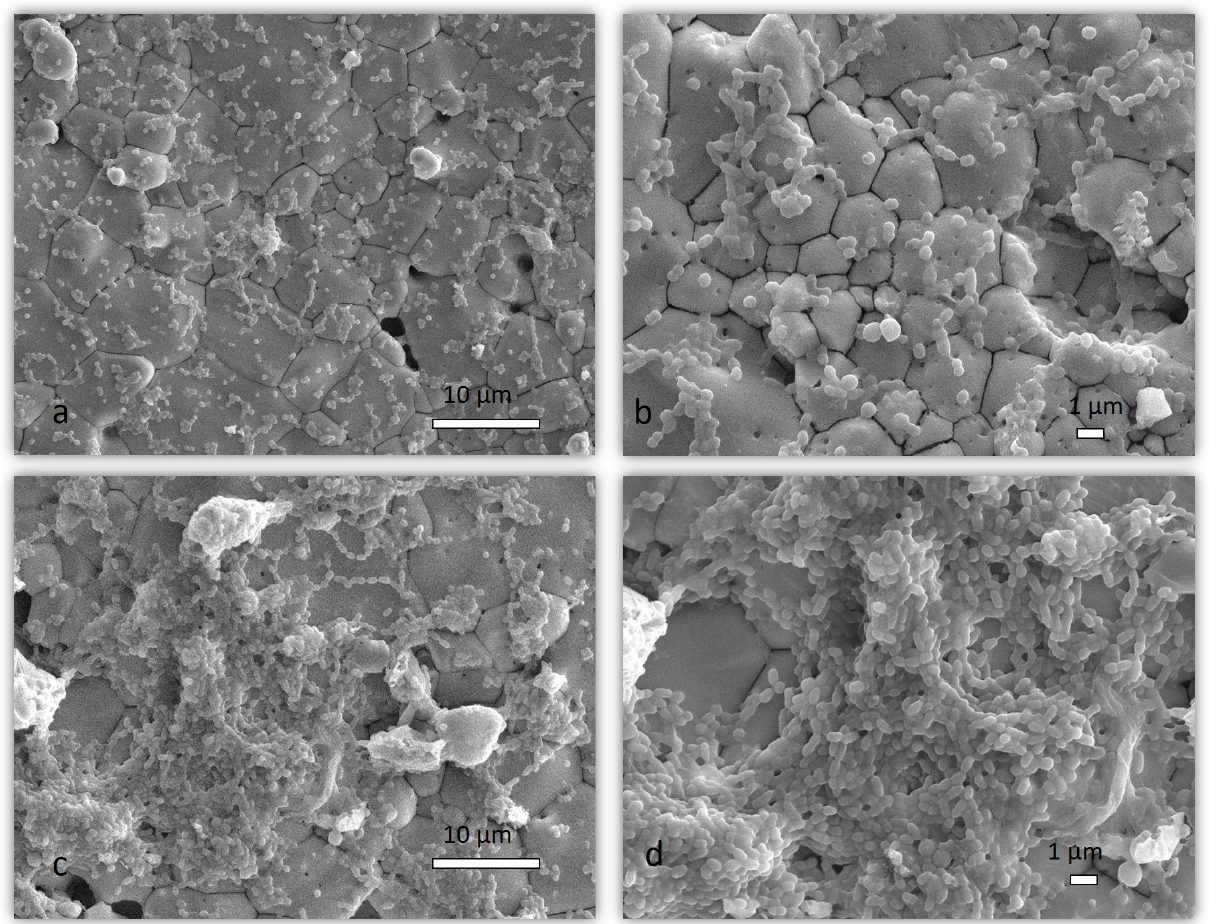
Figure 5. Representative SEM micrographs of a 72-h biofilm on hydroxyapatite. Different magnifications of salivarius mixed biofilm are presented in ( a , b ), while different magnifications of non-salivarius mixed biofilm are presented in ( c , d ); Magnification of 2000 × and 5000 ×.